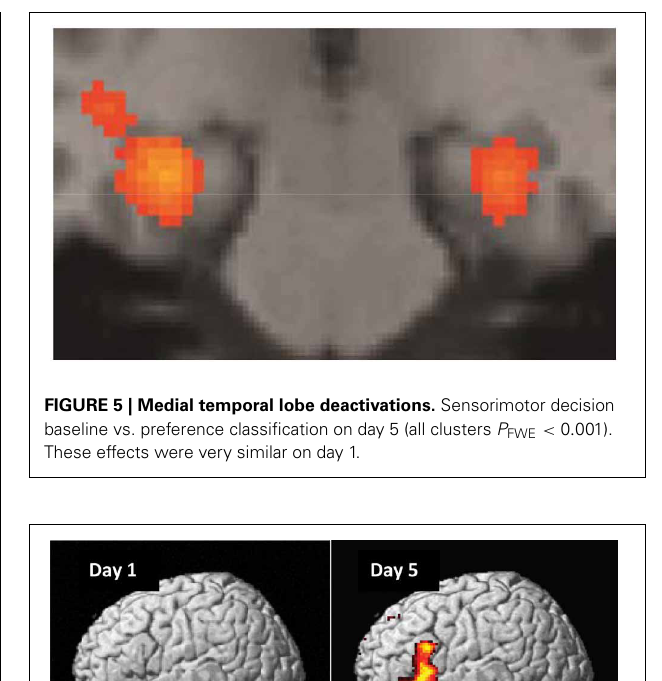
7/40; G > NG, P FWE = 0 . 002) and an interaction in the right pos-